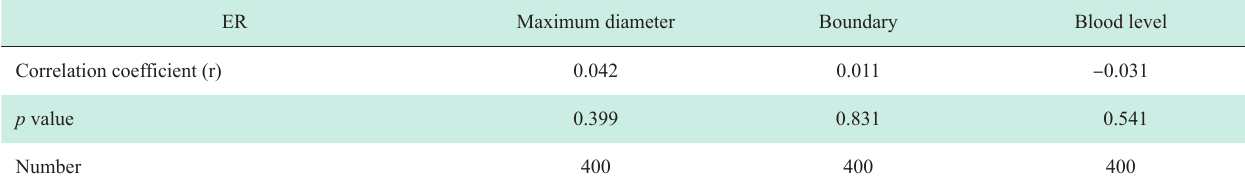
Table1 Correlation between tumor maximum diameter, tumor boundary, blood flow signal classification and ER